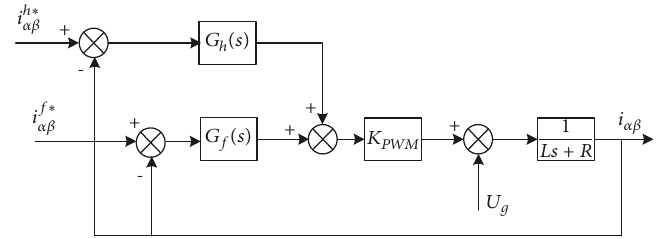
Figure 7: The structure diagram of current inner loop.